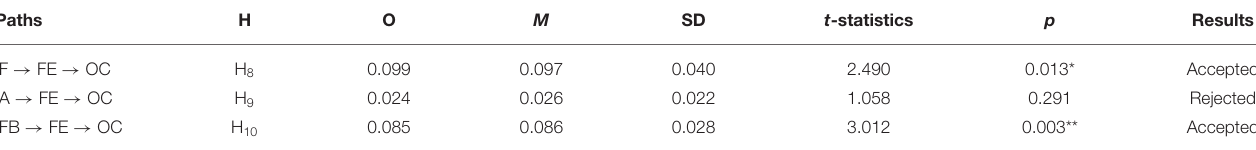
TABLE 5 | Indirect effects of the variable. Paths